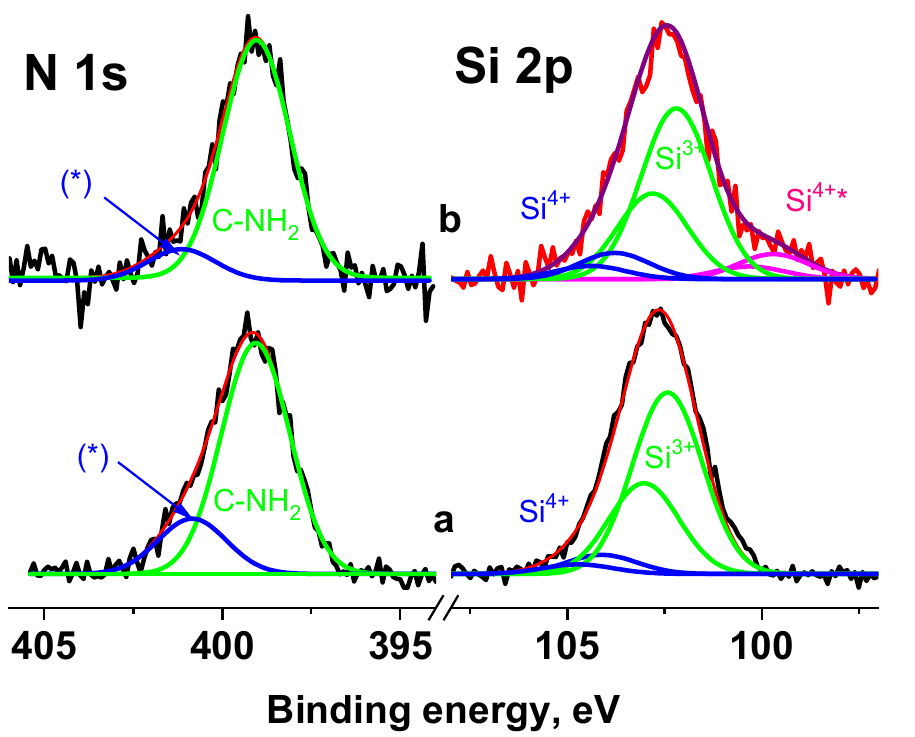
Figure 13. The Si 2p and N 1s spectra of the Ag NPs/HBPAPES/cotton sample measured at U b = 0 V ( a ) and U b = 7 V ( b ), *—differential charging.